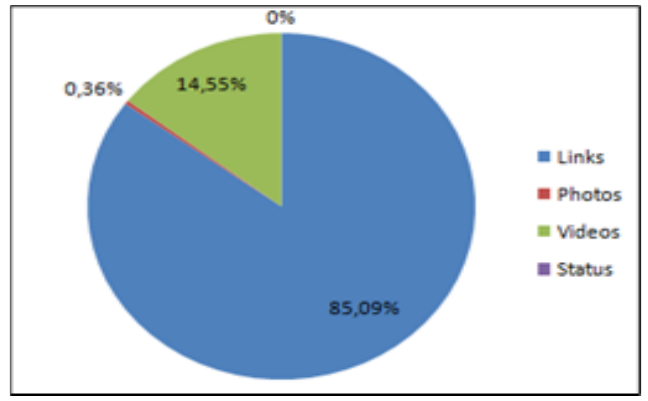
Fig. 2. Percentages of 275 publications by